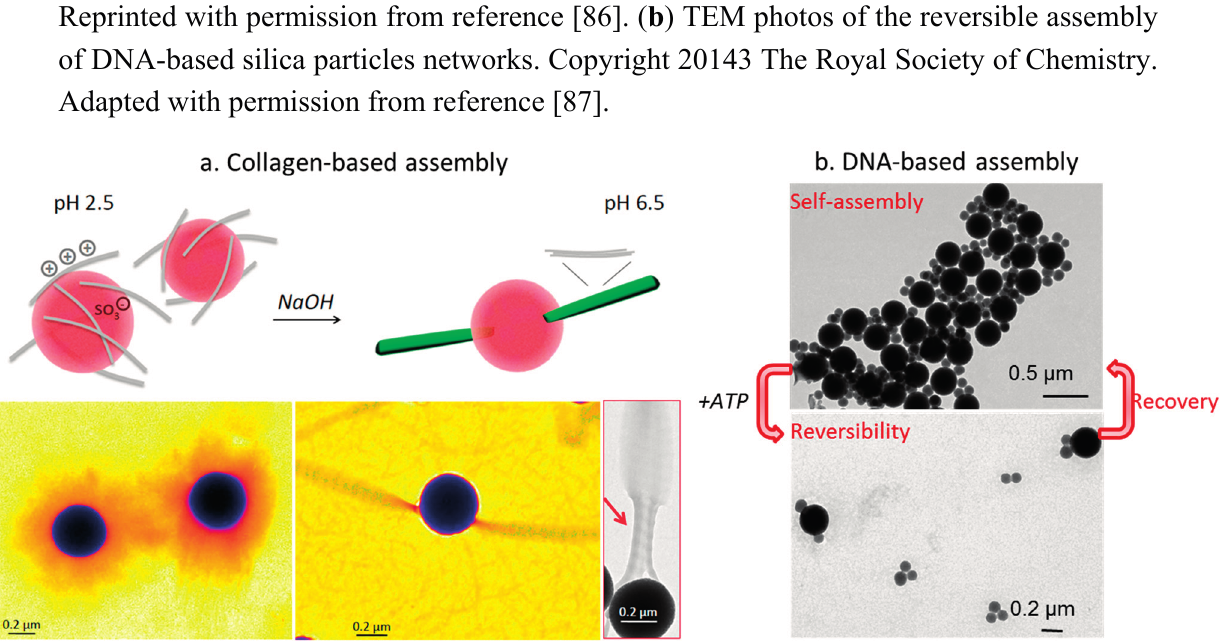
Figure 6. ( a ) Collagen adsorption and fibrillogenesis from sulfonated-modified